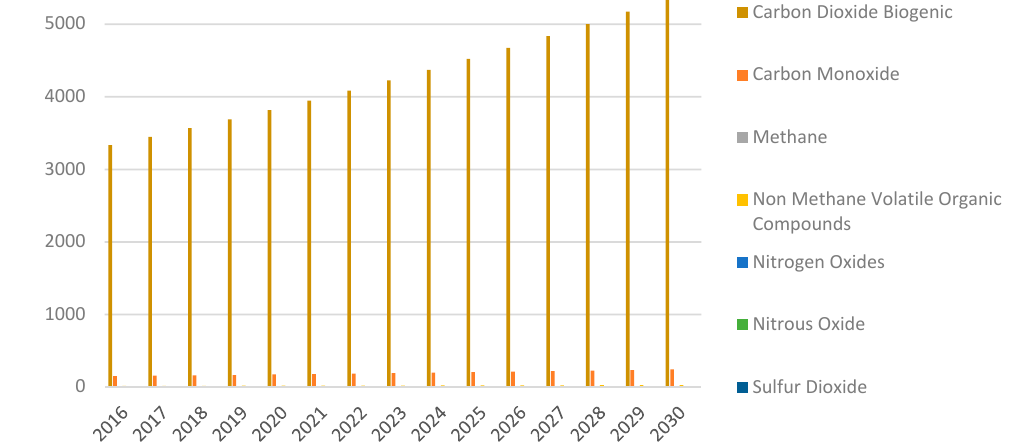
Figure 19. Emissions under the BAU scenario. (Thousands of Metric Tonnes)